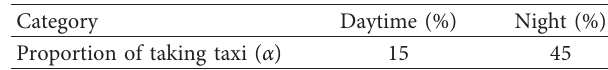
Table 5: Proportion of passengers choosing taxis in Pudong Airport.